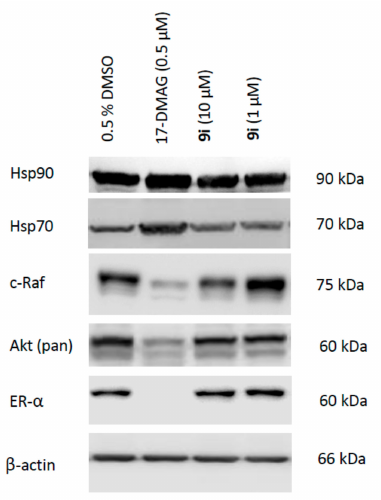
Figure 5. Representative Western blotting for the MCF-7 breast cancer cell line for Hsp90, Hsp70, Akt, c-Raf, and estrogen receptor alpha (ER- α ) after 24 h incubation with compound 9i , 17-DMAG (positive control) and 0.5% DMSO